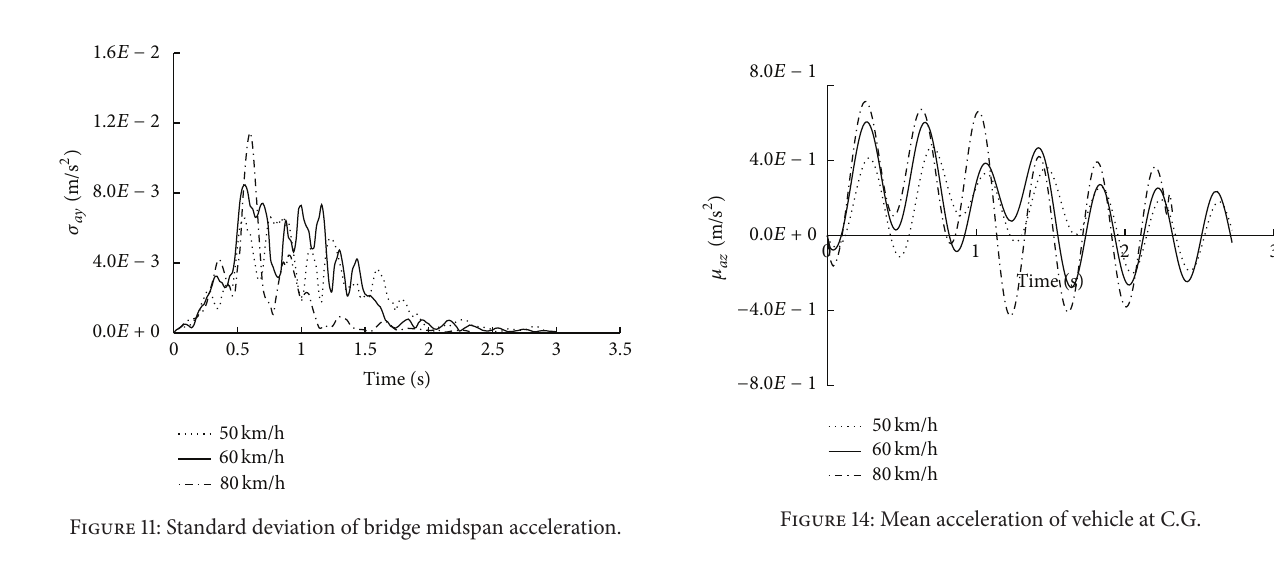
Figure 13: Mean velocity of vehicle at C.G.